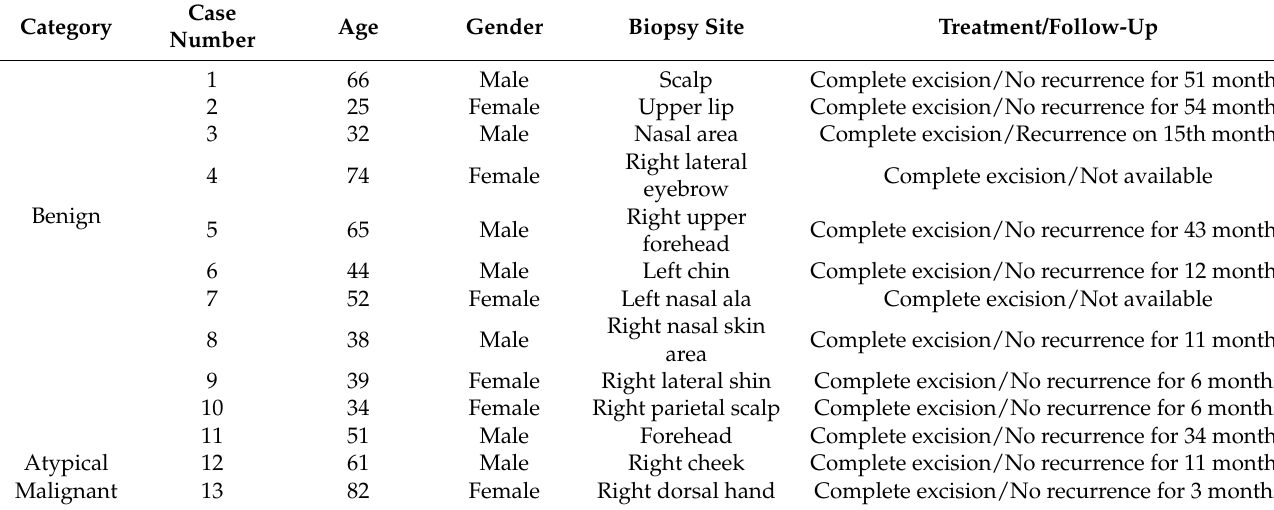
Table 1. Patients’ demographic and follow-up